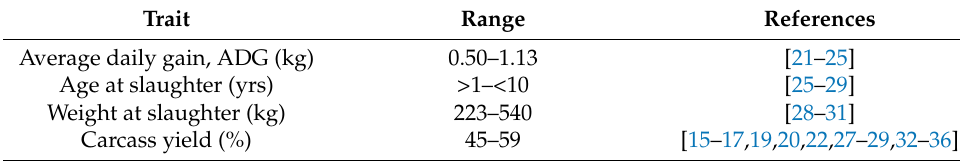
Table 2. Growth and carcass traits of river